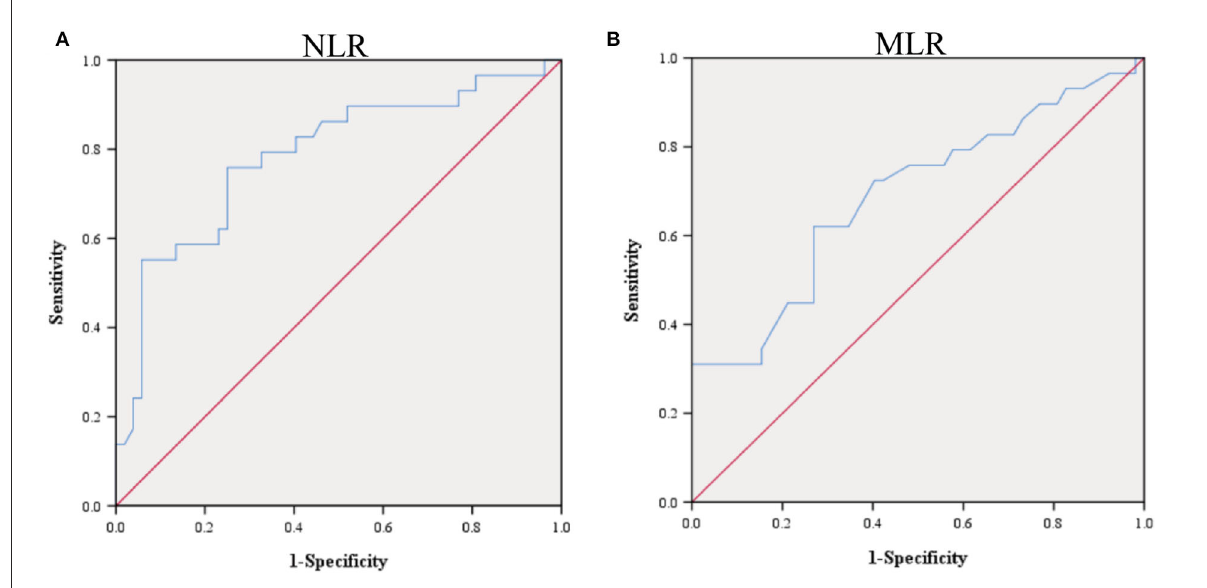
FIGURE1 ROC curves of the predictive value of NLR (A) and MLR (B) for the poor prognosis of VE.